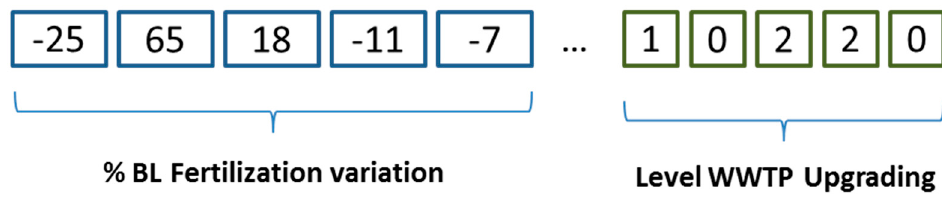
Figure 4. Schematic of the decision variables (chromosome) representing the conservation practices.